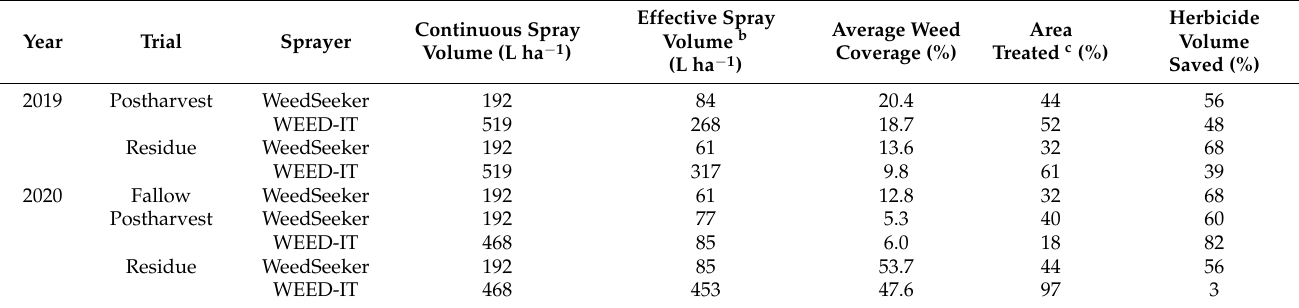
Table 5. Herbicide volume saved by WeedSeeker and WEED-IT in the fallow a , postharvest, and residue trials in 2019 and